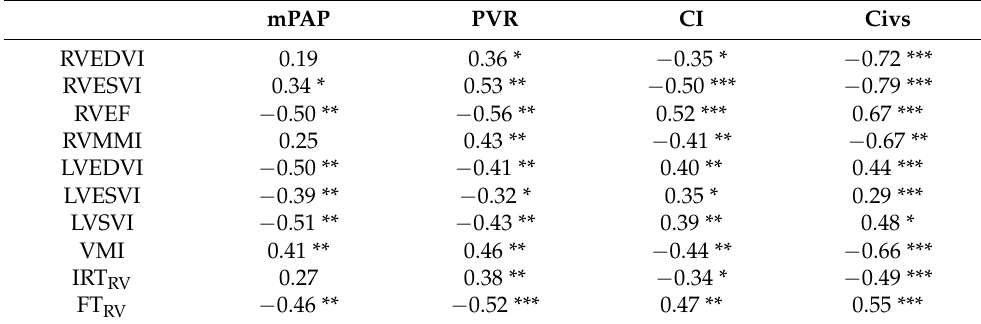
Table 4. Spearman correlations r between the CMR data and RHC data.